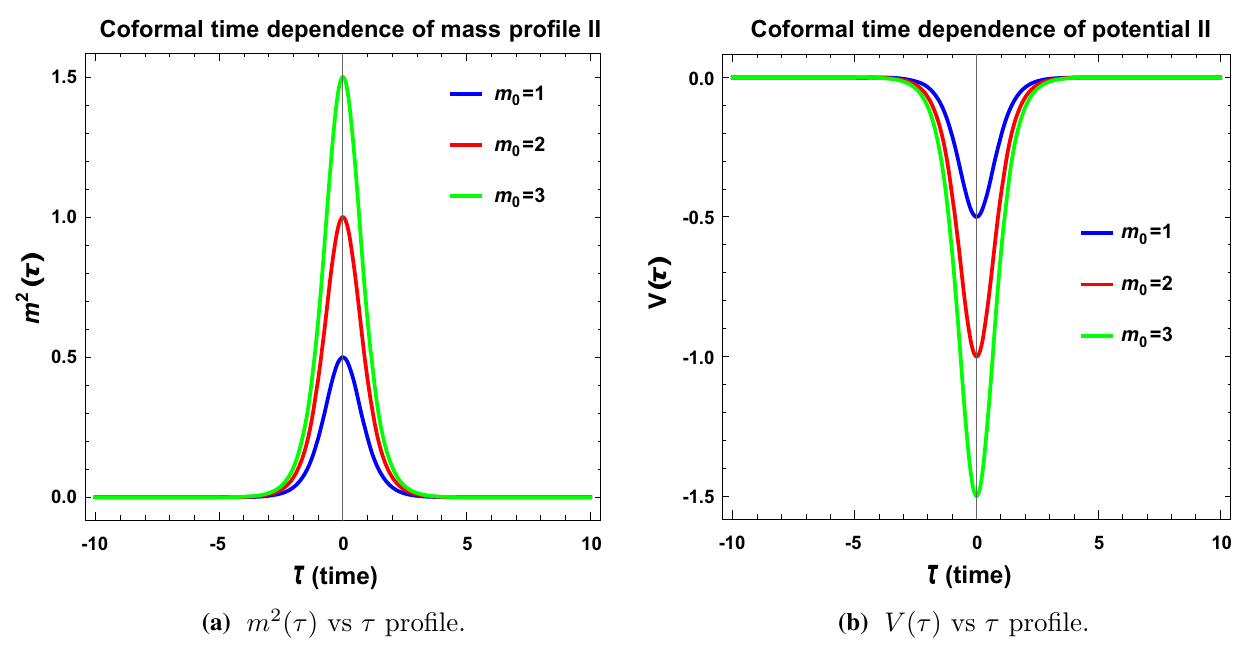
Fig. 10 Conformal time dependent behaviour of the mass profile II and its corresponding potential used in Schrödinger scattering problem is explicitly shown here. Here we fix ρ = 1